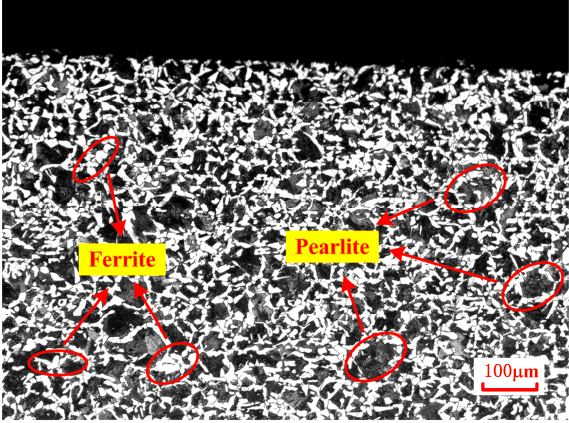
Figure 10. Initial microstructure before grind-hardening experiment by metallurgical microscopy.